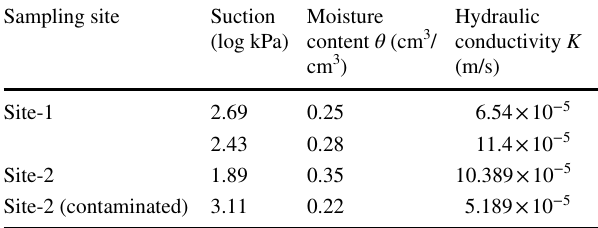
Table 6 Estimation of unsaturated hydraulic conductivity Sampling